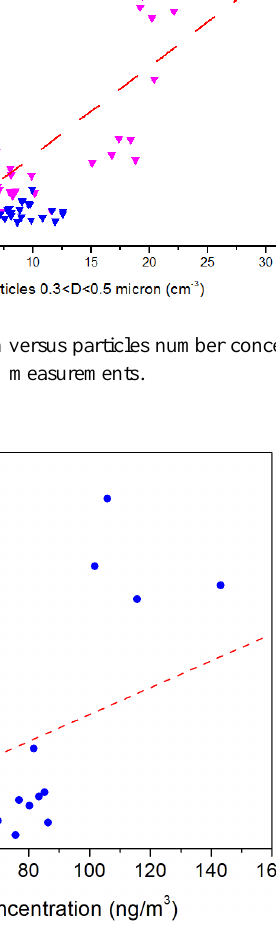
Fig. 12. IN number concentration versus BC concentration during both campaigns on clear days.